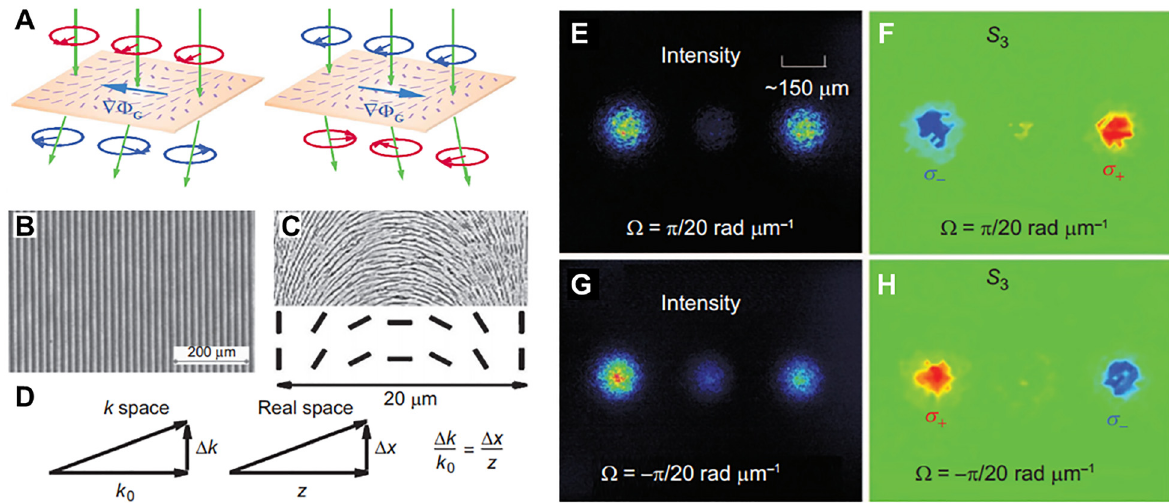
Figure 4: Schematic and experimental demonstration of photonic SHE in a structured metasurface [76]. (A) represent the transition of the spin state when circularly polarized light is transmitted through a structured metasurface with a spin- dependentPBphasegradient ∇ Φ G .Theshortlinemarkedonthemetasurfaceindicatesthelocalopticalaxisdirection.Thegreenarrowsshow the wave vectors. For the incident left-handed circularly polarized light ( σ + , red) and right-handed circularly polarized light ( σ − , blue), the metasurface produces the opposite ∇ Φ G and the opposite spin-dependent momentum displacement. (B) Microscopic photograph of the metasurface.(C)Aschematicillustrationofthedetailedgeometryandlocalopticalaxis(slowaxis)ofthemetamaterialinaperiod(20mm).(D) The mapping relationship between momentum displacement Δ k and induced real space displacement Δ x . After the linearly polarized beam passes through two metasurfaces with completely opposite rotation rates Ω , charge-coupled device records the intensity and the corresponding S 3 parameters, the observation plane is 10 cm away from the metasurface. The experimental results of the metamaterial with Ω = π / 20 rad μ m − 1 are shown in (E) and (F). (G) and (H) The experimental results of the metamaterial with Ω = − π / 20 rad μ m − 1